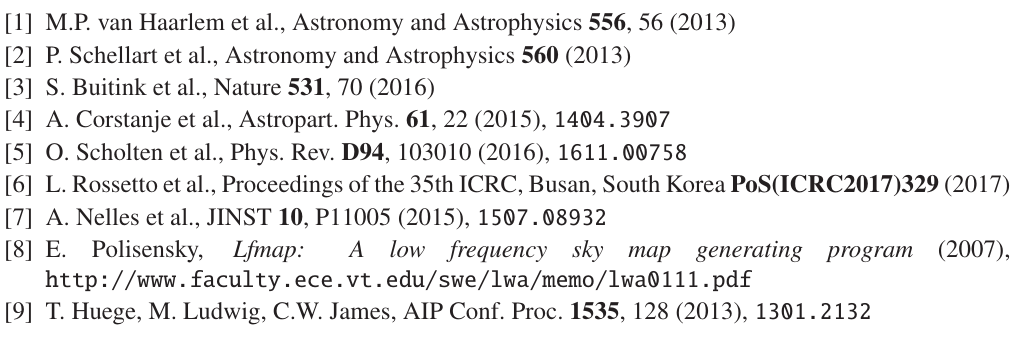
Figure 3. Histogram showing the di ff erence between the slopes before (30–58 MHz) and after (62–78 MHz) the LBA resonance frequency, for 2500 signals. CoREAS simulations are shown, as ∼ well as log slopes for measured power spectra calibrated with the new galaxy method, and the calibrations resulting from di ff erent characterizations of the reference